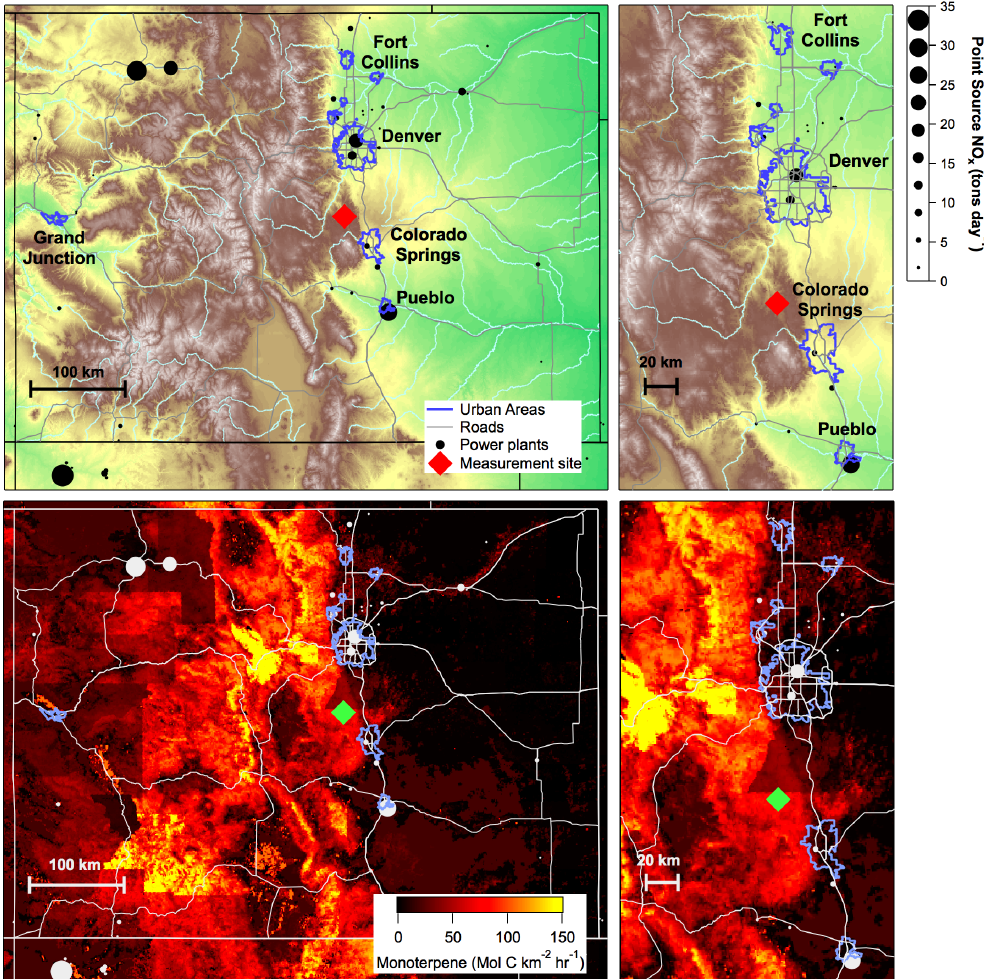
Fig. 2. Map of Manitou Forest Observatory site. Top panels show topography and point sources for NO x . Regional NO x point sources are shown as black/grey dots with size proportional to emissions rate. The Four Corners power plant (lower left of larger map) is not shown on this scale; its emissions of 136tonsday − 1 dwarf all other power plants in this region. The site is 40km northwest of Colorado Springs and 70km southwest of Denver, the two largest urban areas (outlined in blue) in the domain. For discussion of transport to the site, note the South Platte River Valley (rivers shown in aqua) southwest from the Denver urban area towards the field site (red/green diamond). Bottom panels show monoterpene emission potential, calculated using the BEIS